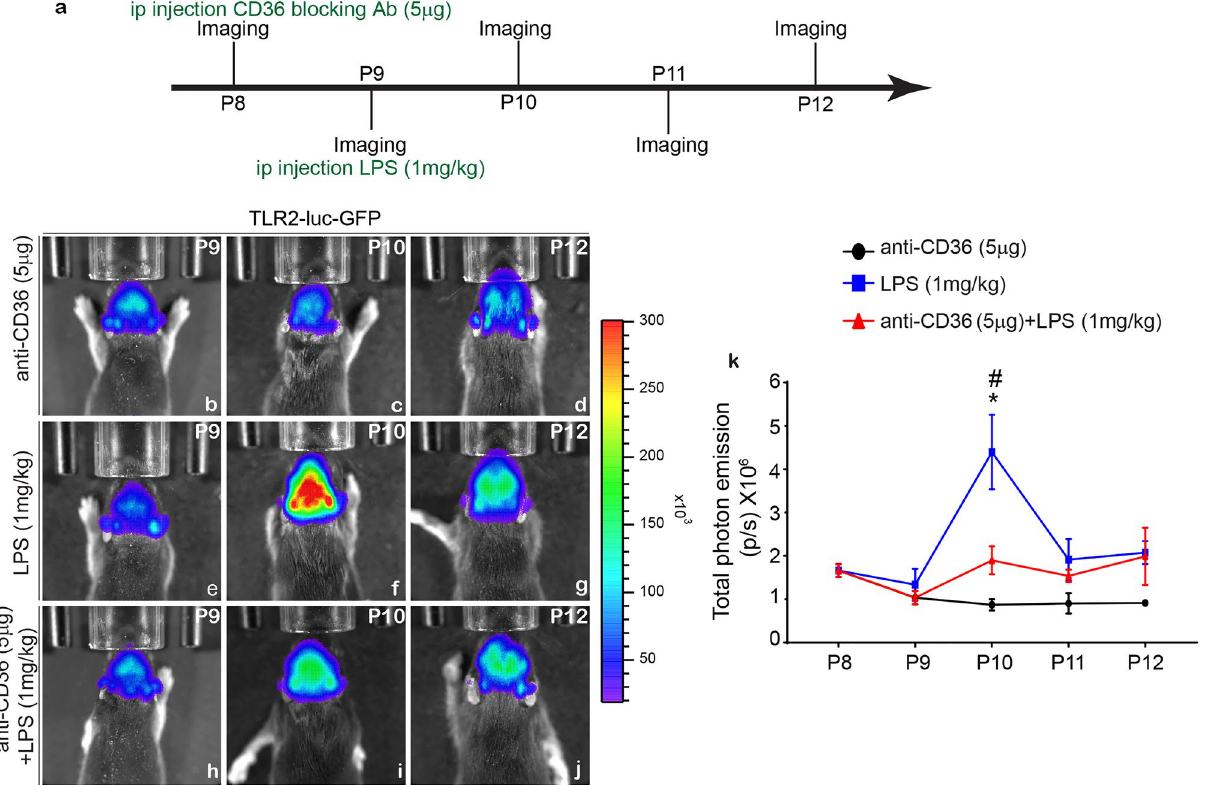
Figure 1. Real-time bioluminescence imaging of theTLR2 signals after LPS challenge. ( a ) Schematic presentation of experimental protocol used for the treatment with anti-CD36 antibodies in P8-P9 mice. ( b – j ) Representative images of the bioluminescent signals recorded from the brains of living P10–P12 TLR2-luc- GFP mice treated with anti-CD36 antibody ( b – d ), LPS ( e – g ) or pre-treated with anti-CD36 antibody followed by systemic LPS injection ( h – j ). Note that a robust TLR2 induction 24 h post-LPS treatment is significantly reduced when the pups are pre-treated with anti-CD36. The scales on the right are the colour maps for source intensity. The scale ranges differ at individual ages. ( k ) Quantification of the in vivo bioluminescence data from P8–P12 (in photons per second, p/s). One way ANOVA (anti-CD36 vs LPS *p ≤ 0.05, LPS vs anti-CD36 + LPS *p ≤